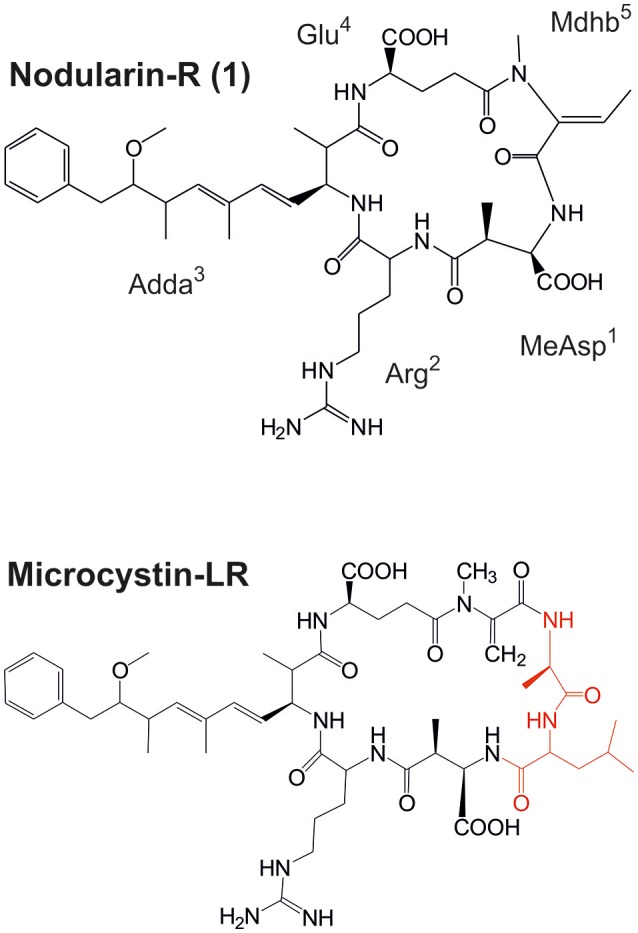
Structures of nodularin-R and microcystin-LR, which is the most common variant of microcystin (amino acids marked red are not present in nodularins). MeAsp, D-erythro-β-methylaspartic; Adda, 3-amino-9-methoxy-10-phenyl-2,6,8-trimethyl-deca-4(E),6(E)-dienoic acid; Mdhb, N-methyl-dehydrobutyric acid.